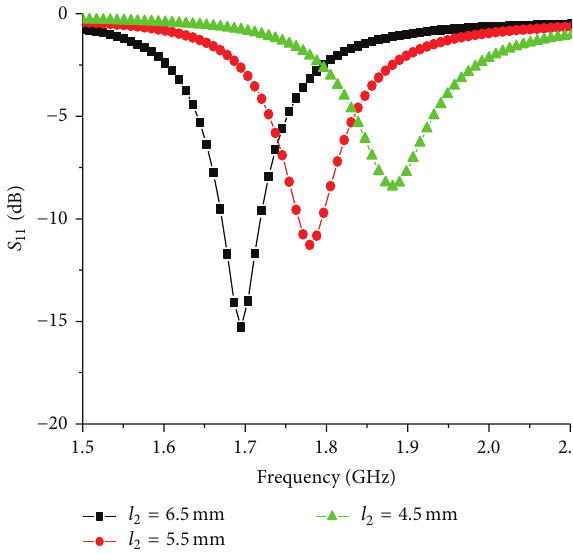
Figure 4: Simulated |𝑆 11 | for antenna operating at various 𝑙 2 . Table 1: Optimal dimensions of the designed antenna.